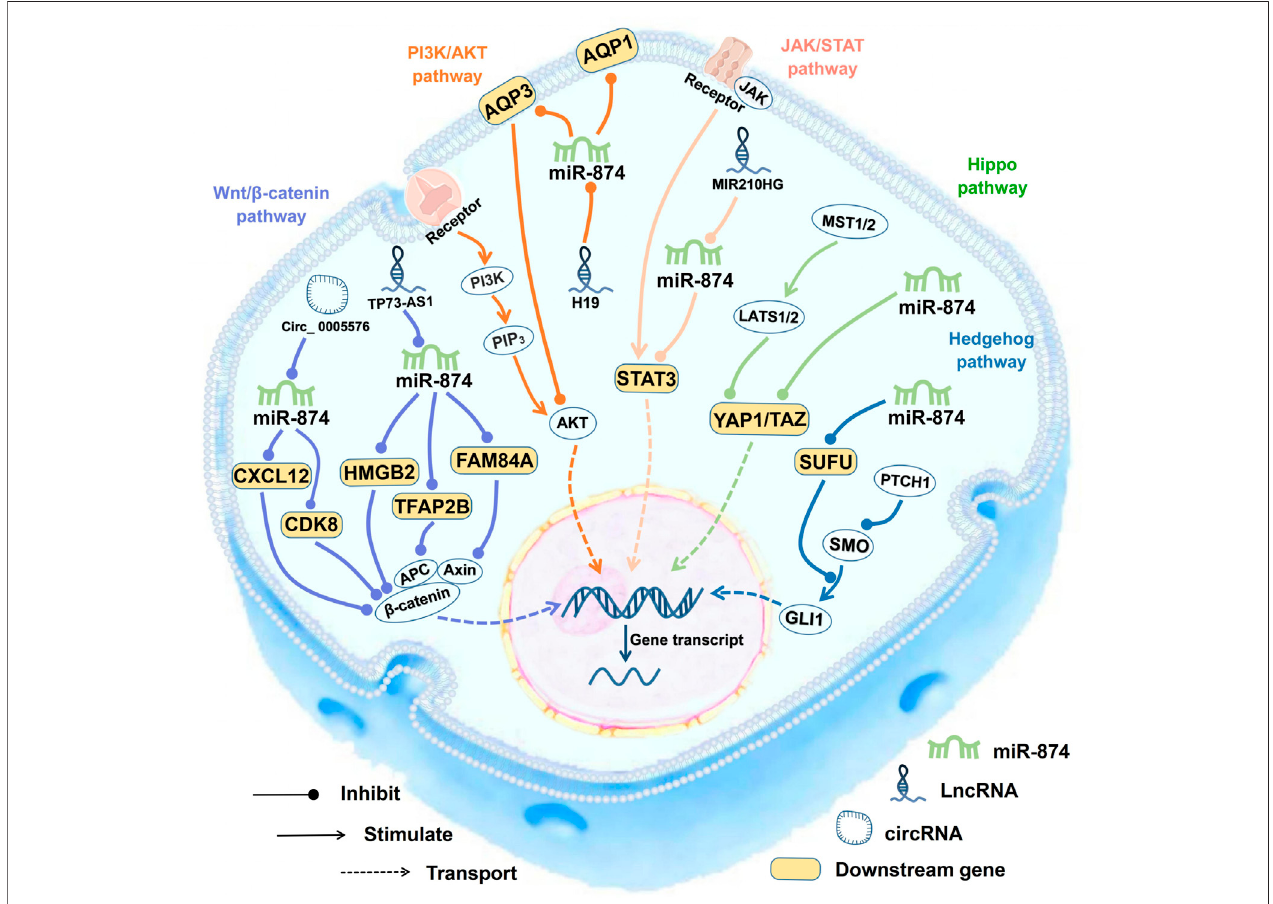
FIGURE 3 | miR-874 regulate many biological processes within the cell. The target genes of miR-874 are involved in at least fi ve classical signaling pathways, including the Wnt/ β -catenin signaling pathway, P13/AKT signaling pathway, Hippo signaling pathway, JAK/STAT signaling pathway, and Hedgehog signaling pathway. EMT, epithelial-mesenchymal